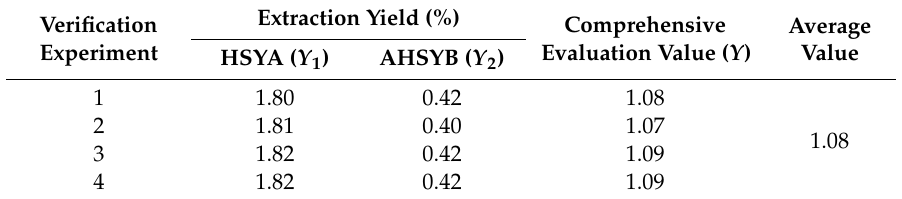
Table 2. Verification test under optimized conditions from the response surface.